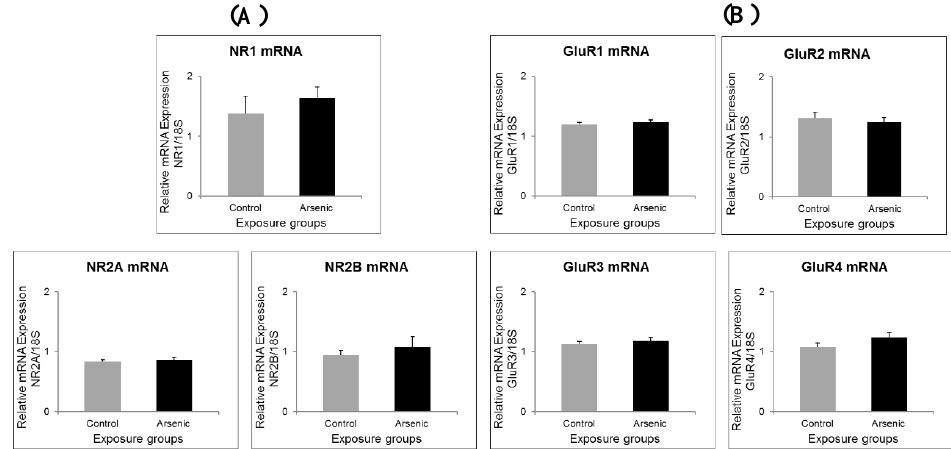
Figure 3. Messenger RNA expression level of ( A ) NMDA receptor subunits, and ( B ) AMPA receptor subunits in the prefrontal cortex of the control group and the arsenic-exposed group of 15–17-week-old male mice. Each bar represents the mean ± SE ( n = 7).